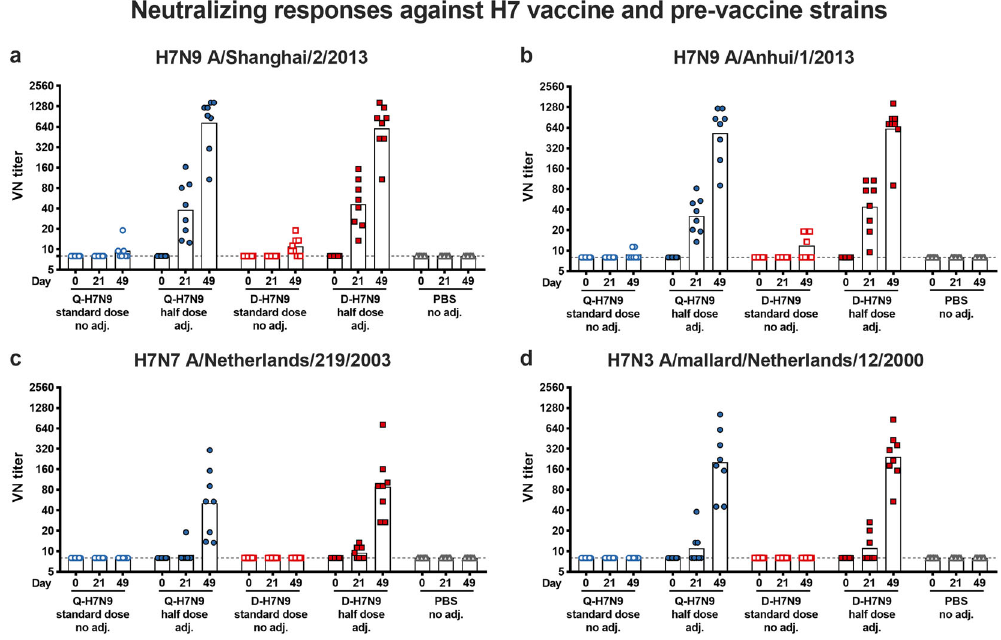
Fig. 3 Microneutralization titers (VN) against homologous H7N9 viruses and heterologous H7N3 and H7N7 viruses. VN titers against H7N9 A/Shanghai/2/2013 ( a ), H7N9 A/Anhui/1/2013 ( b ), H7N7 A/Netherlands/219/2003 ( c ), and H7N3 A/mallard/Netherlands/12/2000 ( d ) are shown on the y -axis. The x -axis shows the timepoints (day 0, 21, 49) and the treatment groups are indicated. The dashed gray lines represent the limit of detectable HI titers against homologous H7N9 A/Shanghai/2/2013 titers of 5 against the tested viruses. All animals in the non- virus with a reciprocal geometric mean titer (GMT) of 7 in the Q- adjuvanted standard-dose HA groups had non-detectable HI titers H7N9 and 12 in the D-H7N9 group. Three animals had detectable after the fi rst immunization at day 21 against the four viruses HI titers against H7N9 A/Anhui/1/2013, but no HI-active antibodies tested (Fig. 2). After the second vaccination, some animals had